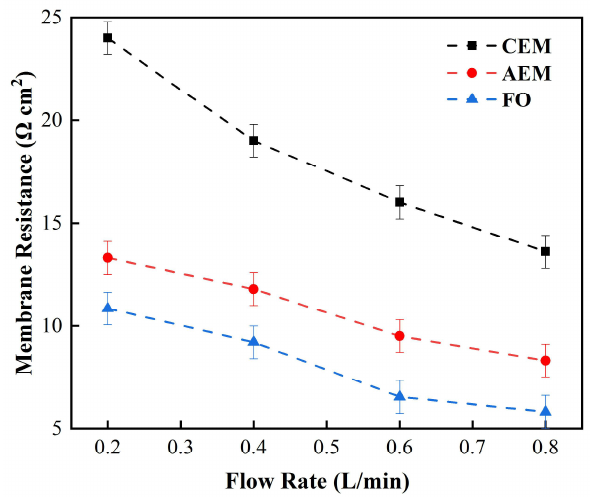
Figure 5. Relationship between the measured membrane electrical resistance and solution circulation velocity (0.5 M